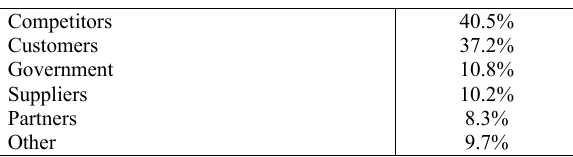
Table 7: Time spent focusing on different targets Competitors Customers